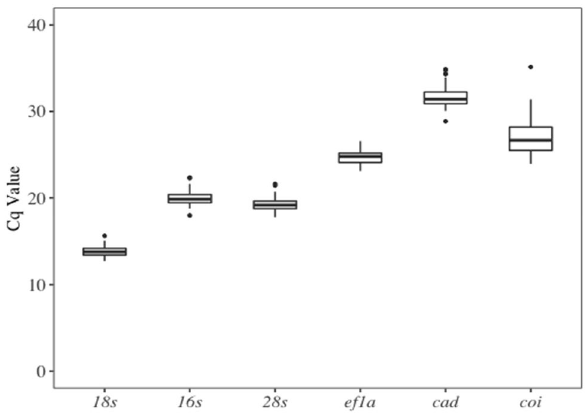
Figure 2. Cq values for each candidate reference gene across all treatments. Boxes encompass the 25th to 75th percentiles, and whiskers represent 1.5 times the interquartile range. Outliers are indicated by dots.